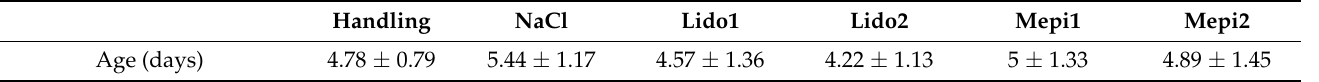
Table 3. Mean values and standard deviation of age, body weight, local anesthetic dosing, and end-tidal isoflurane concentration during injection and